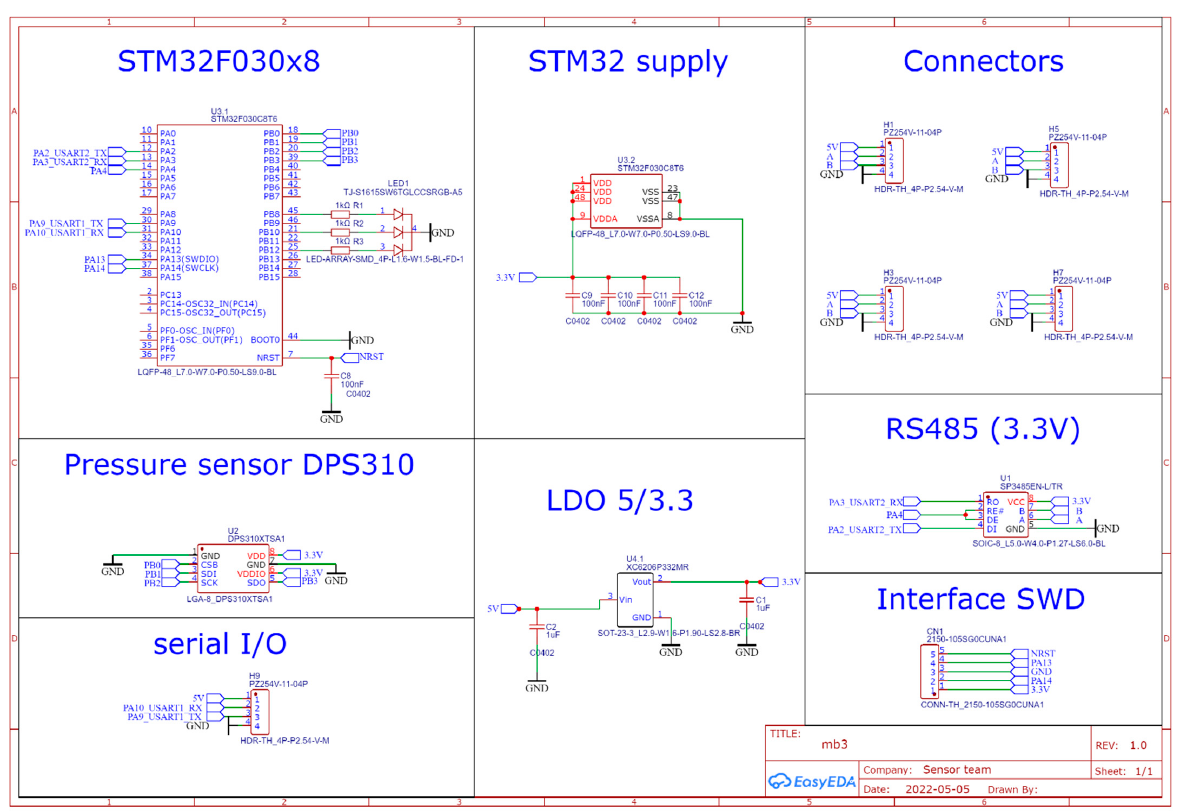
Figure 2. Schematic diagram of the system with the main components of the measurement system (microcontroller and pressure